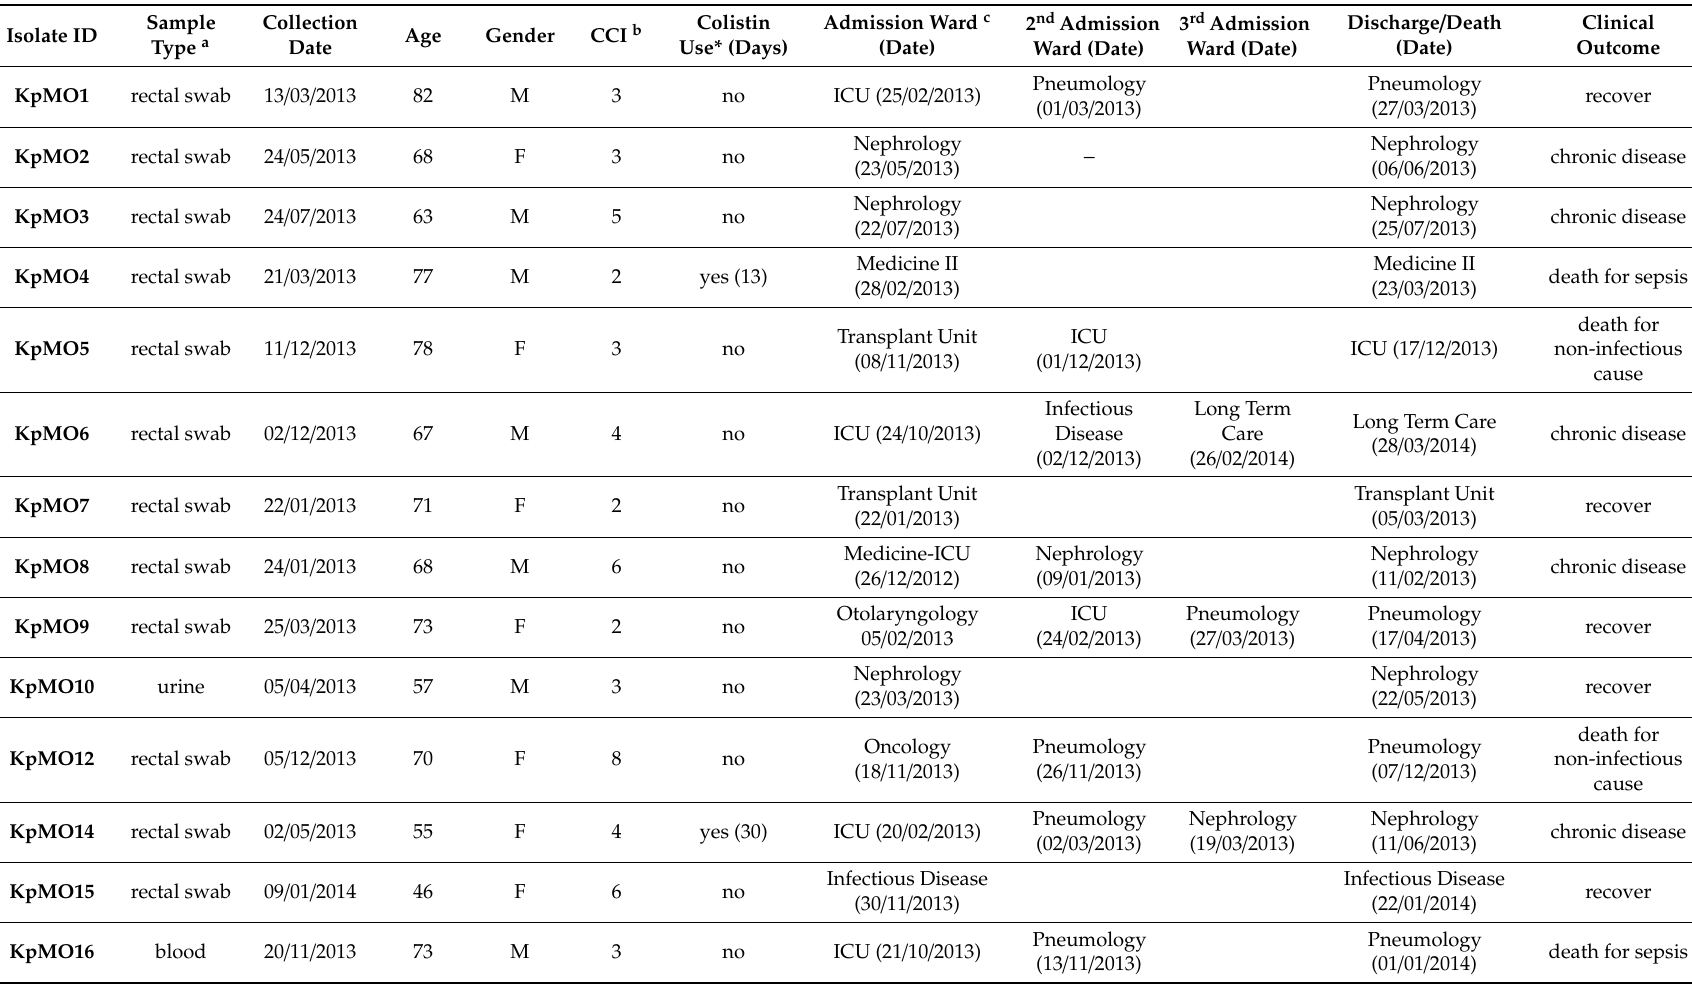
Table 3. Isolates and patients’ characteristic. a , BAL, Bronchoalveolar lavage; b , Charlson Comorbidity Index; c, ICU, Intensive Care Unit; * Colistin treatment